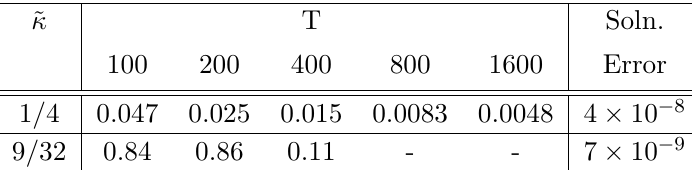
Table 3 . mLCE for ˜ β = 0 integrated for different times and different values of ˜ κ with initial conditions (4.34). The error is that of the numerical solution for the largest- T solution quoted, not the mLCE, with the accuracy of shorter T solutions being significantly